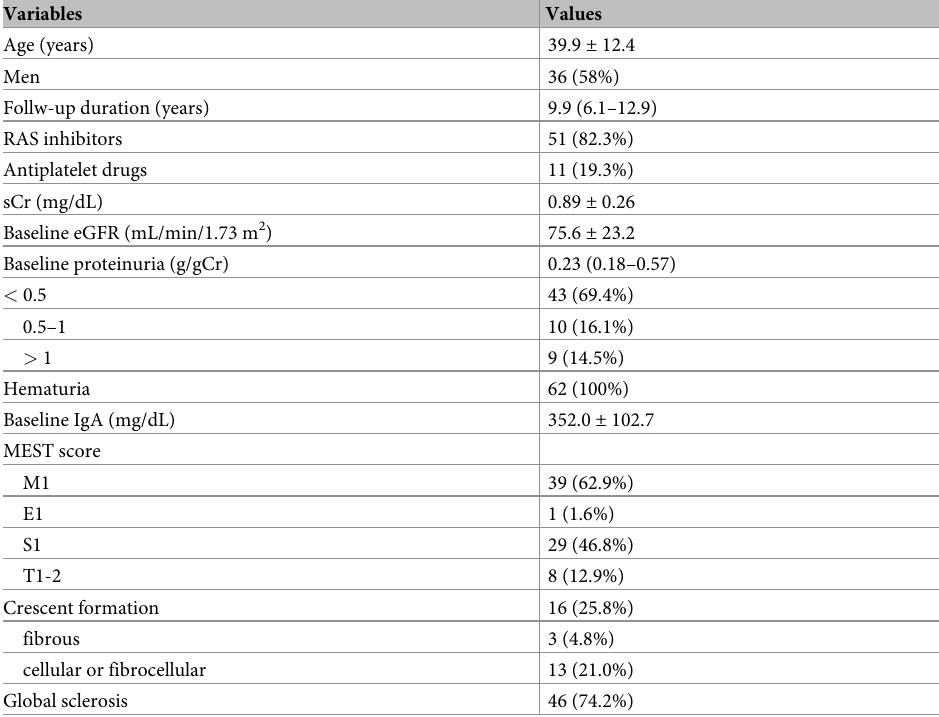
Table 1. Clinical characteristics of included patients (n =